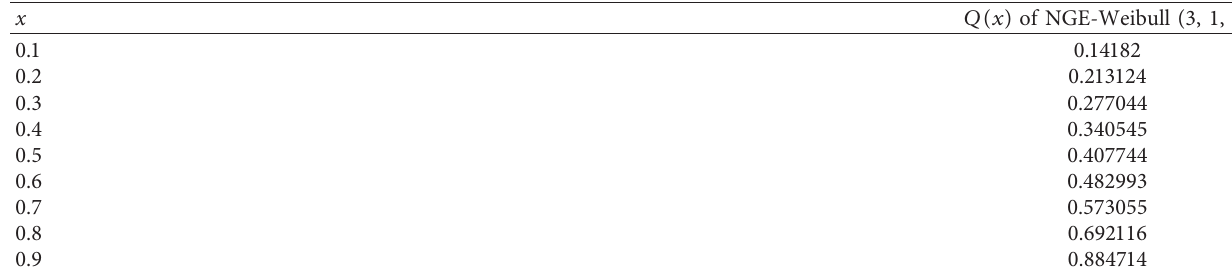
Table 1: Some quantile values.